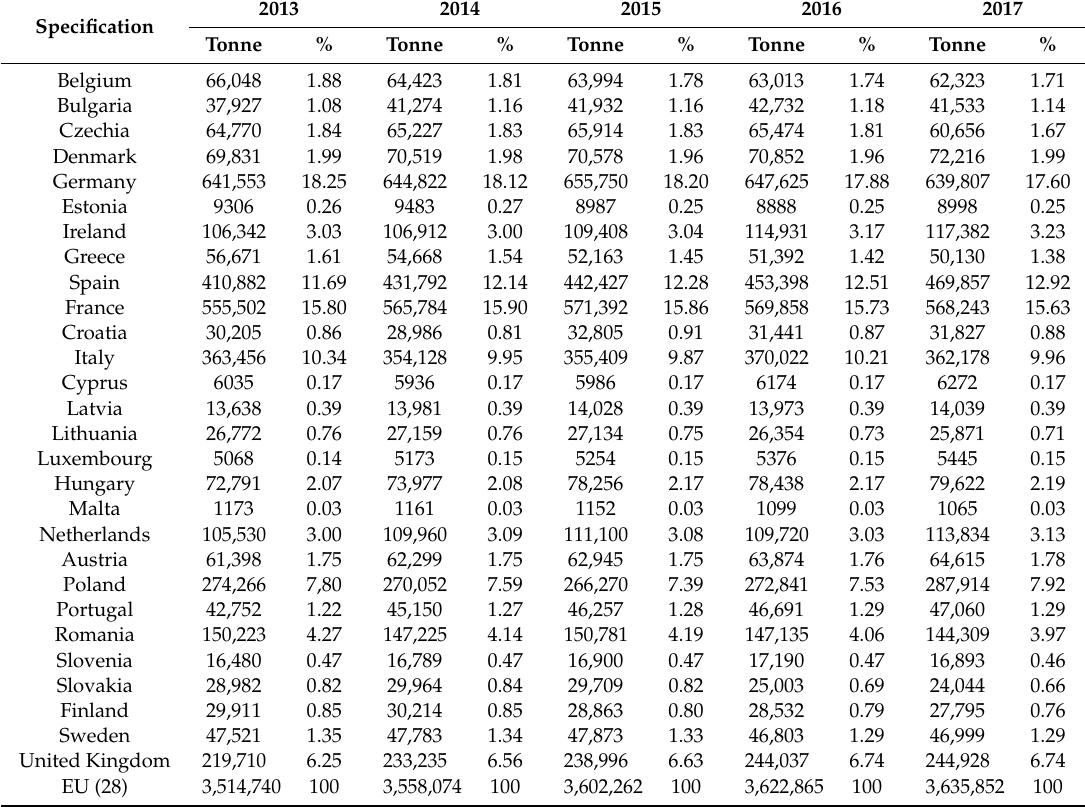
Table 1. Agricultural ammonia emissions in the EU-28 in 2013–2017